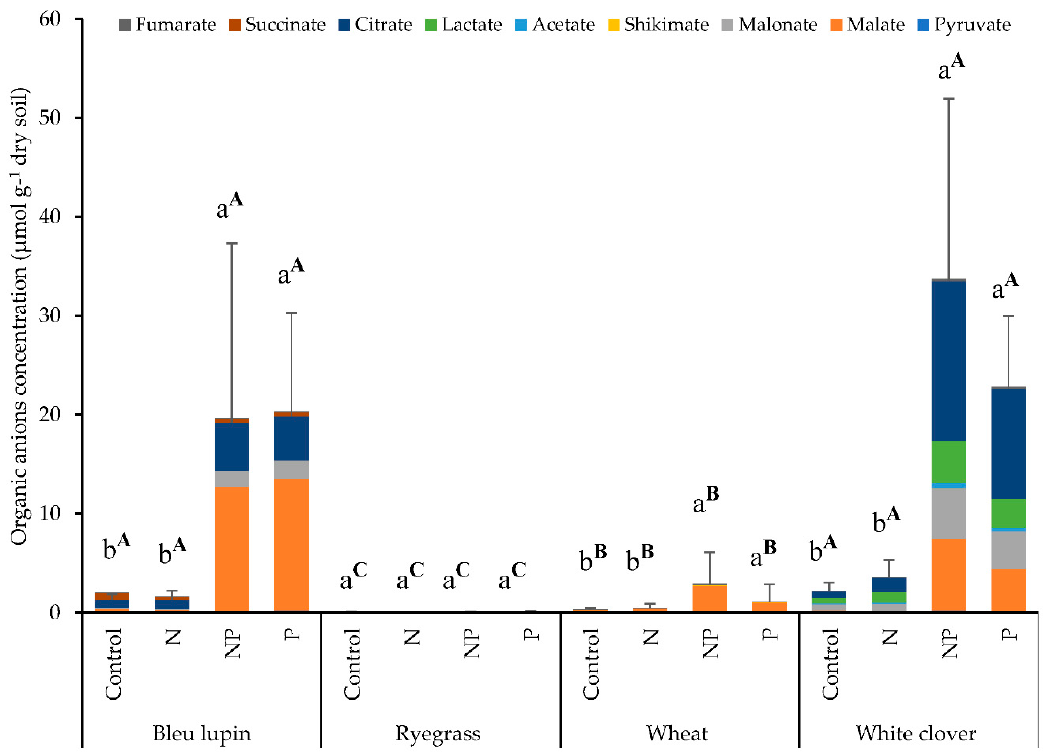
Figure 3. Concentrations of organic anions and their compositions in the rhizospheres of blue lupin, wheat, ryegrass, and white clover for the control (0N, 0P), P (0N, 33P), N (200N, 0P), and NP (200N, 33P) treatments. Di ff erent letters represent a significant di ff erence ( p < 0.05) among nutrient treatments for the same plant. Di ff erent superscript letters represent a significant di ff erence ( p < 0.05) among plant species for the same nutrient treatment.